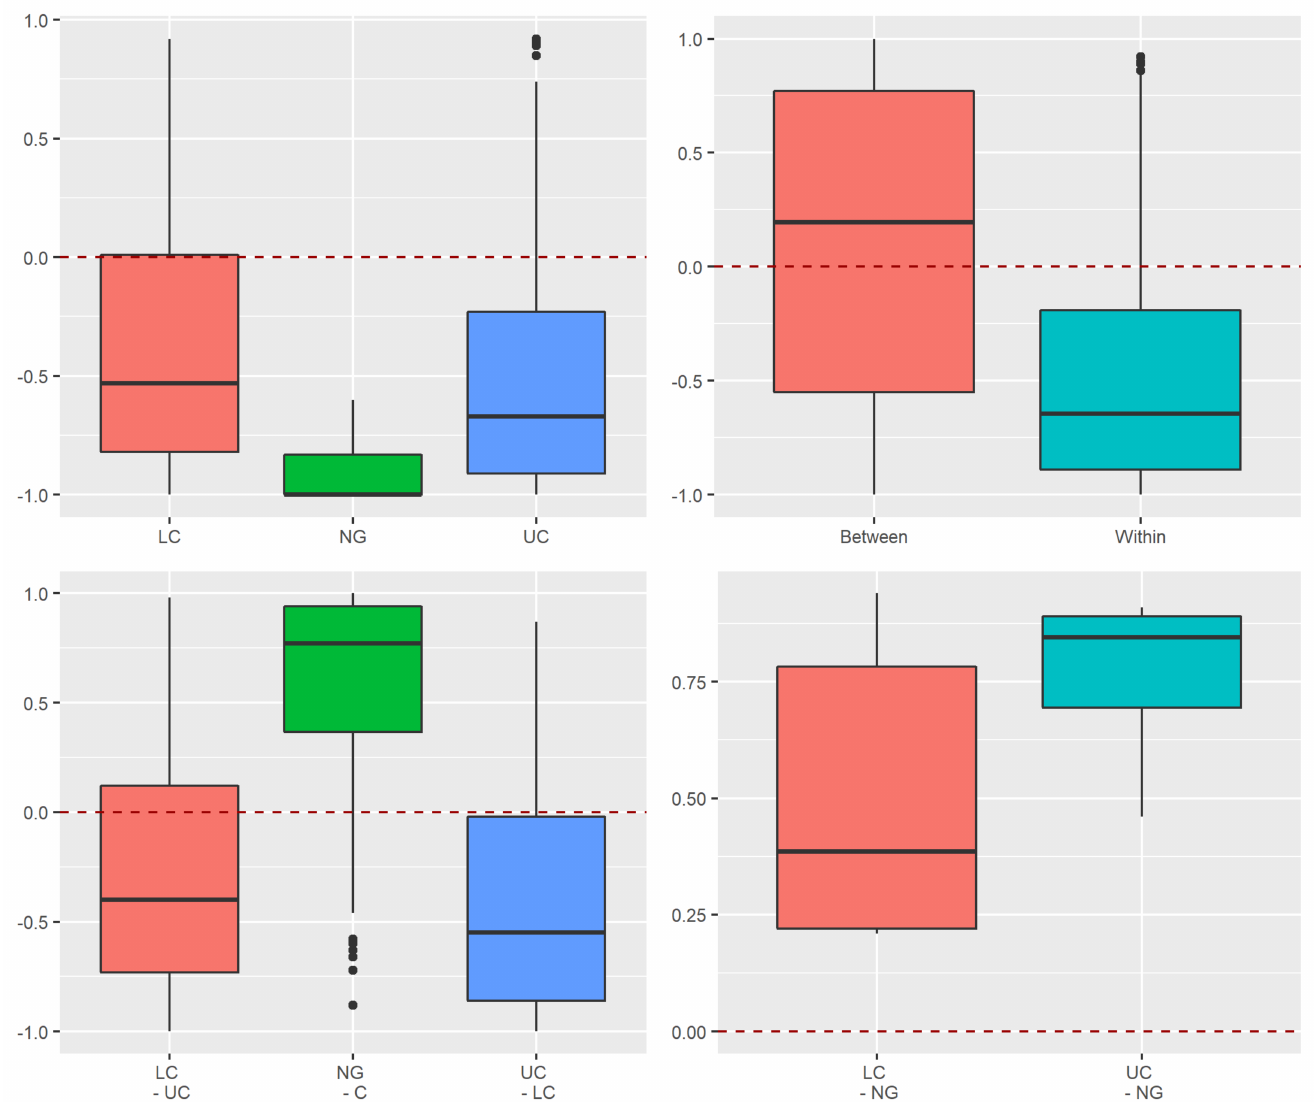
Figure A10. Deviation of the beta diversity from the diversity expected by the null hypothesis per stratum for the rare beetle species, rarity classification according to the octaves. NG—near-ground stratum, LC—lower canopy, UC—upper canopy. Comparisons within a stratum are comparisons of two traps of the same stratum. Comparisons between strata are comparisons of two traps from two different